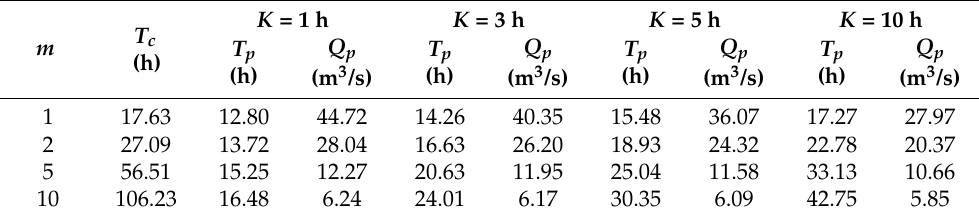
Table 1. Comparison of concentration times ( T c ), peak times ( T p ) and peak flows ( Q p ) of the Clark’s IUHs derived with different m and storage coefficient ( K ) for a circular basin with its area of 188.50 km 2 and the channel velocity of 1 km/h.